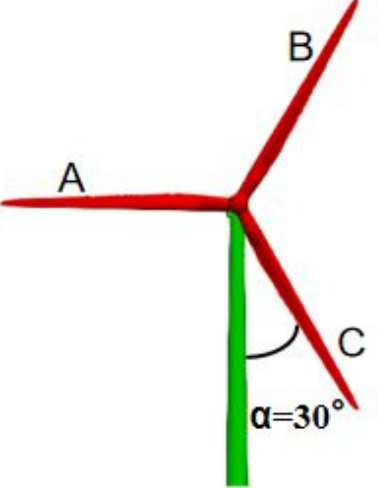
Figure 6. Schematic diagram of wind-turbine phase angle and blade